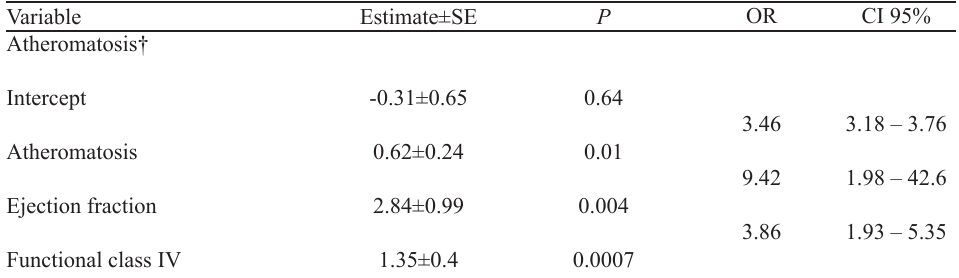
Table 4. Multivariate analysis of the occurrence of stroke in patients undergoing cardiovascular surgery.